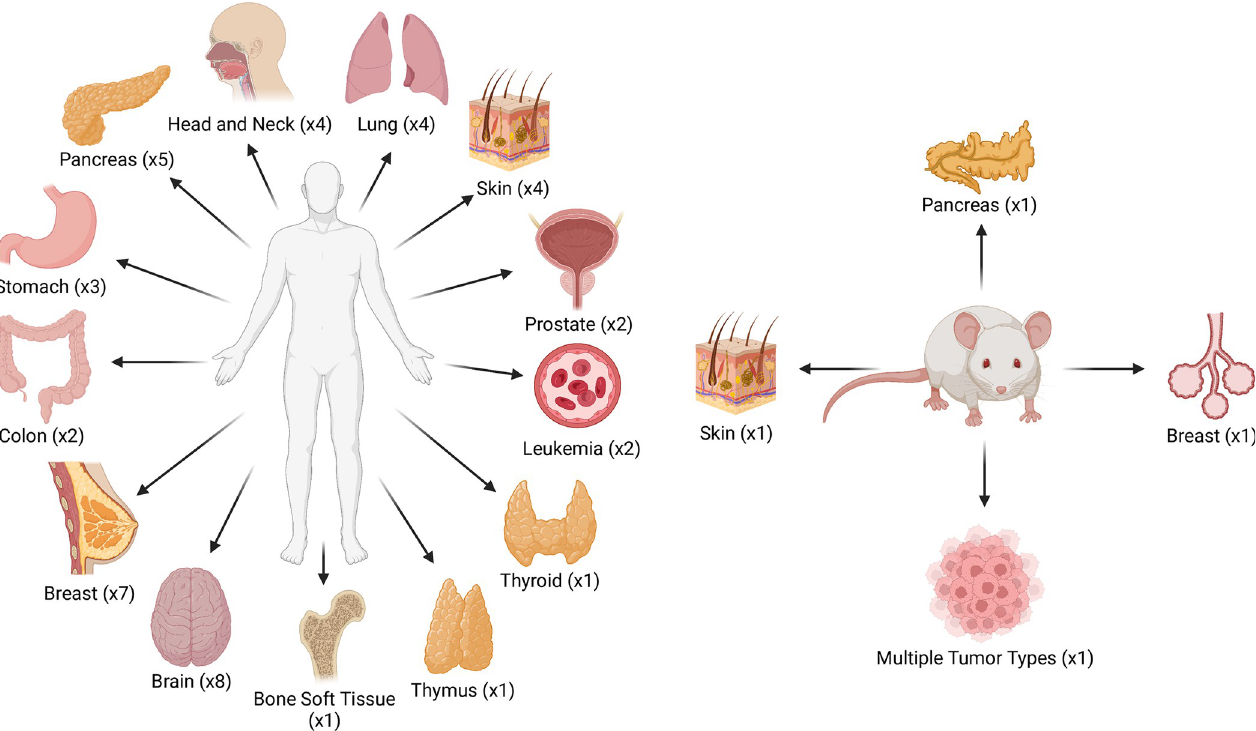
Fig 1. A visualisation of the various tissue types included in TMExplorer. TMExplorer includes 48 TME scRNA-seq datasets from 26 different human cancer types from 13 different sites and 4 different mouse cancer types. TMExplorer is generalizable and extendable, and the new datasets are added to the database as they become available. Fig 1 is created with